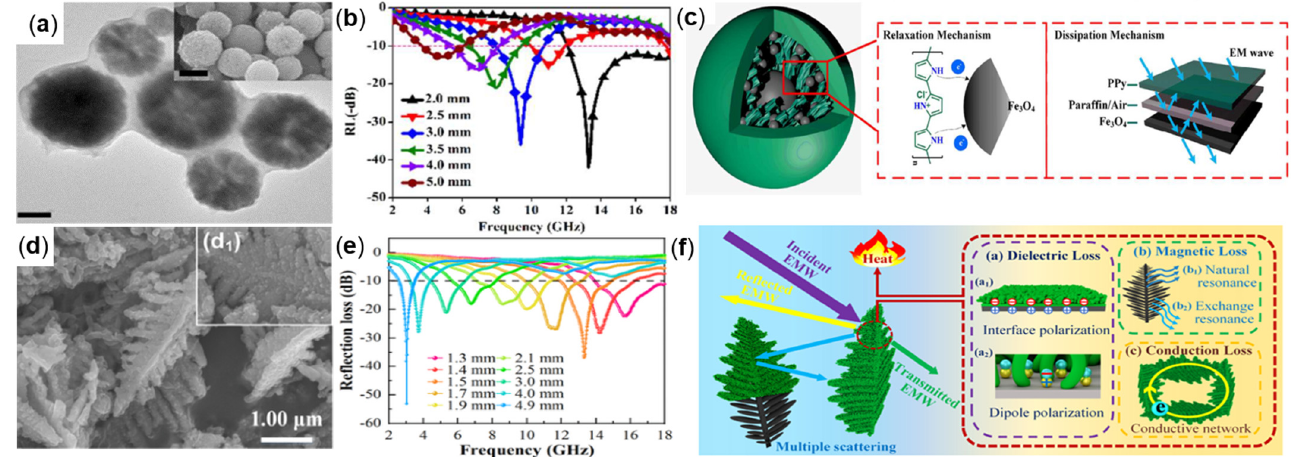
Figure 13. ( a ) SEM, ( b ) RL plot of Fe 3 O 4 @PPy, and ( c ) wave absorption mechanism of Fe 3 O 4 @PPy composites, reproduced with permission from Ref. [101], Copyright 2017, American Chemical Society. ( d ) SEM, ( e ) RL plot of Fe 3 O 4 @PANI, and ( f ) the EMW absorption mechanism of dendritic Fe 3 O 4 @PANI composites, reproduced with permission from Ref. [102], Copyright 2021, Elsevier.